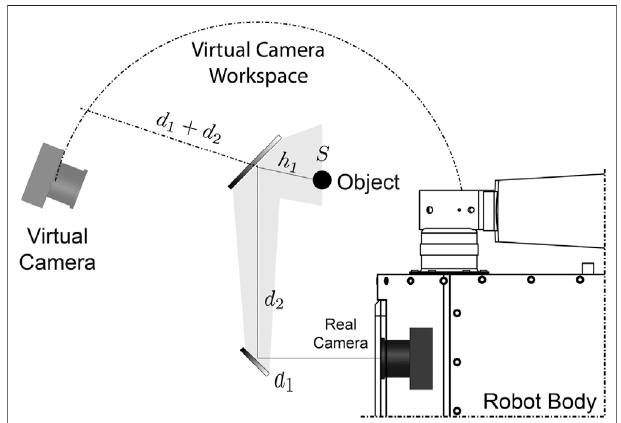
FIGURE 4 | Virtual camera workspace. Since d 1 + d 2 remains constant, the locus where the camera moves is an arc of radius r (cid:1) d 1 + d 2 for 2D projections,and thesurfaceofanspherefora3Dspacewiththesame